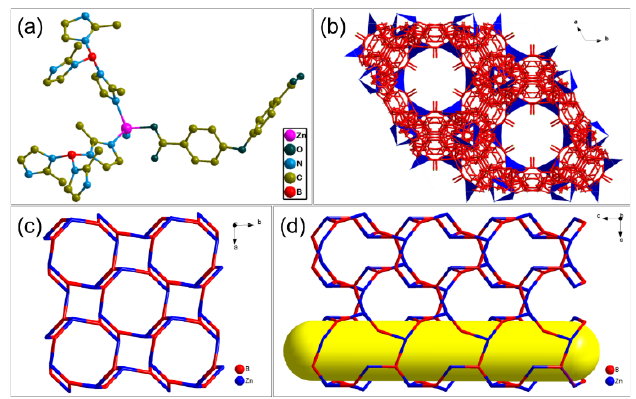
Figure 9. ( a ) The coordination environment of Zn-BIF; ( b ) the 3D framework with 1D channels; and ( c ), ( d ) the topological structure of Zn-BIFs. Reprinted with permission from Reference 56.